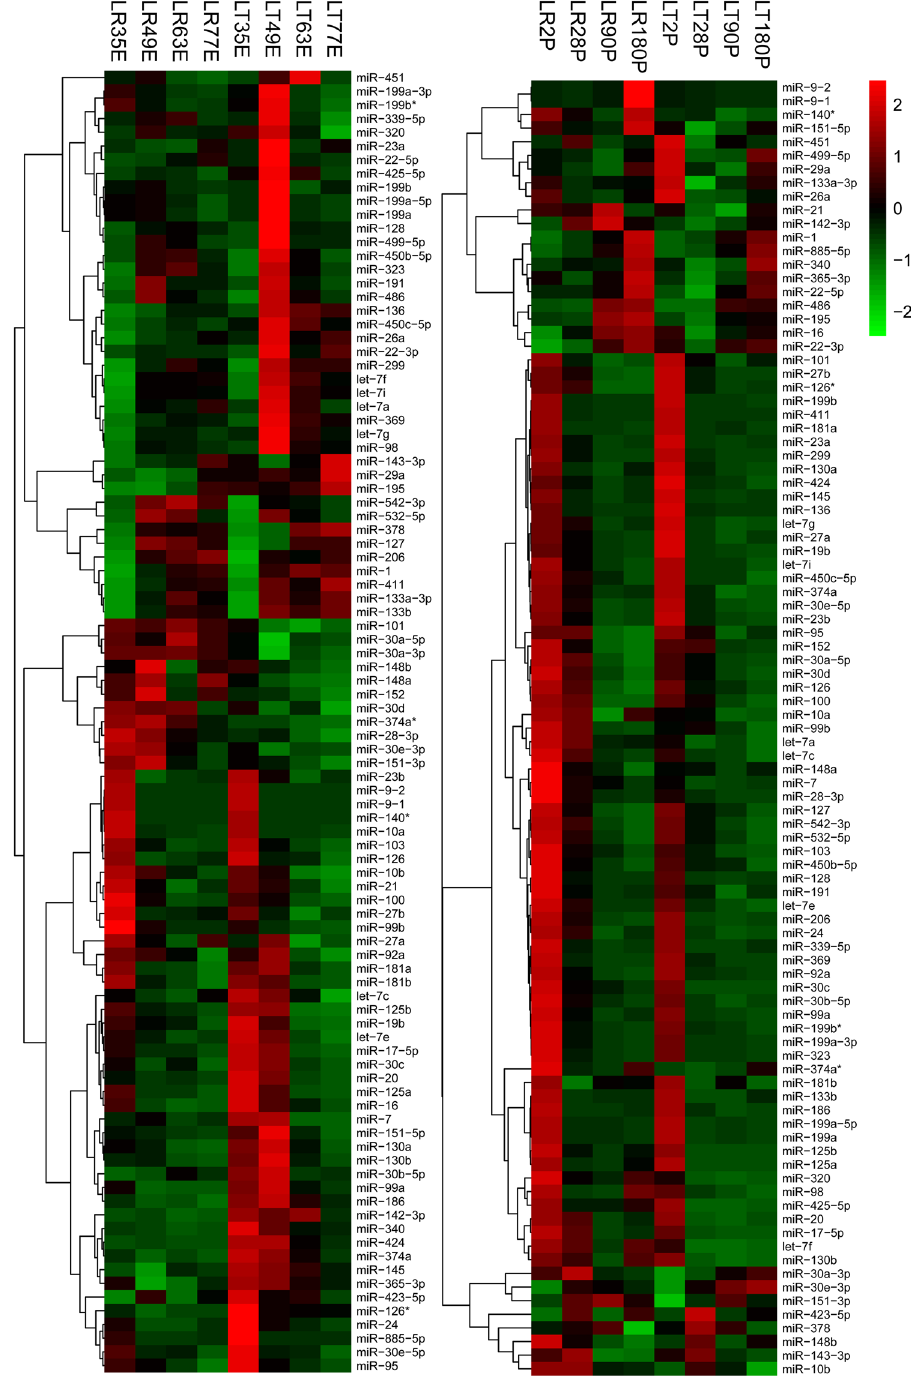
Figure 2. Expression pattern analysis of most abundant miRNAs at G1 and G2 in both breeds. The figure shows heatmaps of DE miRNAs between LR and LT at G1 (95 miRNAs, left) and G2 (96 miRNAs, right). The highest to lowest fold changes are marked from red to